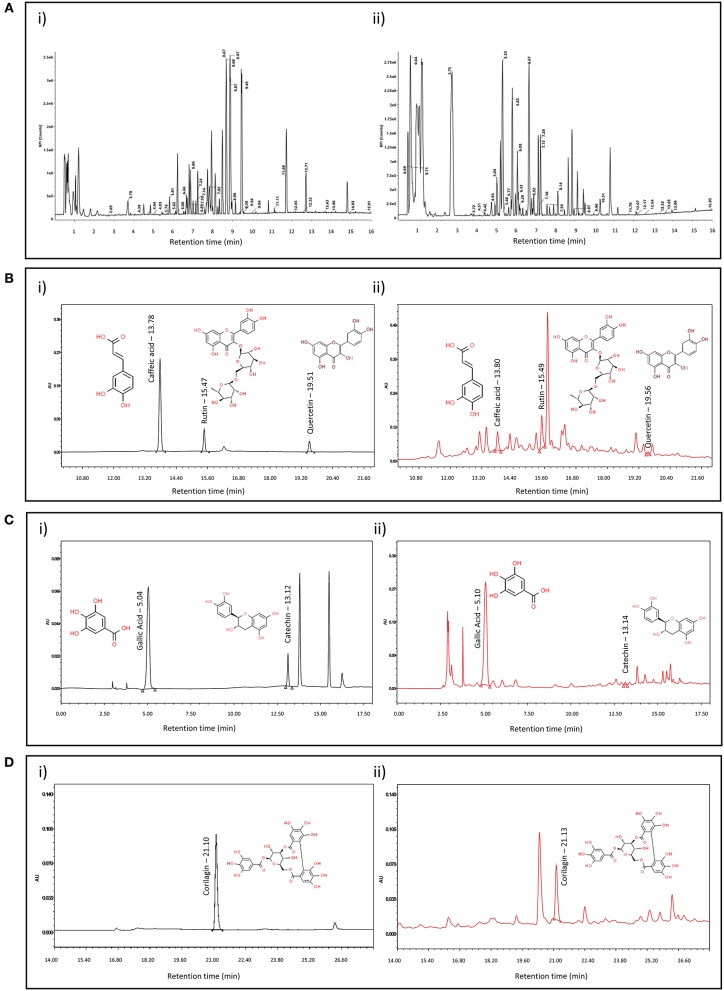
Plant metabolite analysis of Divya Sarva-Kalp-Kwath (SKK): Aqueous extract of the SKK was screened for plant metabolites using liquid chromatography (LC)-based mass spectroscopy (MS). Spectral analysis revealed the presence of (A, i) 46 metabolites were detected in the positive mode and (A, ii) 48 metabolites were detected in the negative mode at different retention time (RT; min) (see Table 1). Using High Performance Liquid Chromatography (HPLC) analysis, SKK was analyzed and quantified for the metabolites, (B, i) Standards of caffeic acid, rutin, and quercetin, (B, ii) SKK contents of caffeic acid, rutin, and quercetin detected at 325 nm, (C, i) standards of gallic acid and catechin, (C, ii) SKK contents of gallic acid and catechin detected at 270 nm, and (D, i) standards of corilagin, (D, ii) SKK contents of corilagin detected at 270 nm. Gallic acid (RT: 5.10 min), catechin (RT: 13.14 min), caffeic acid (RT: 13.80 min), rutin (RT: 15.50 min), quercetin (RT: 19.56 min), and corilagin (RT: 21.13 min) were detected at their respective retention time (RT) in the developed and validated analytical HPLC method.